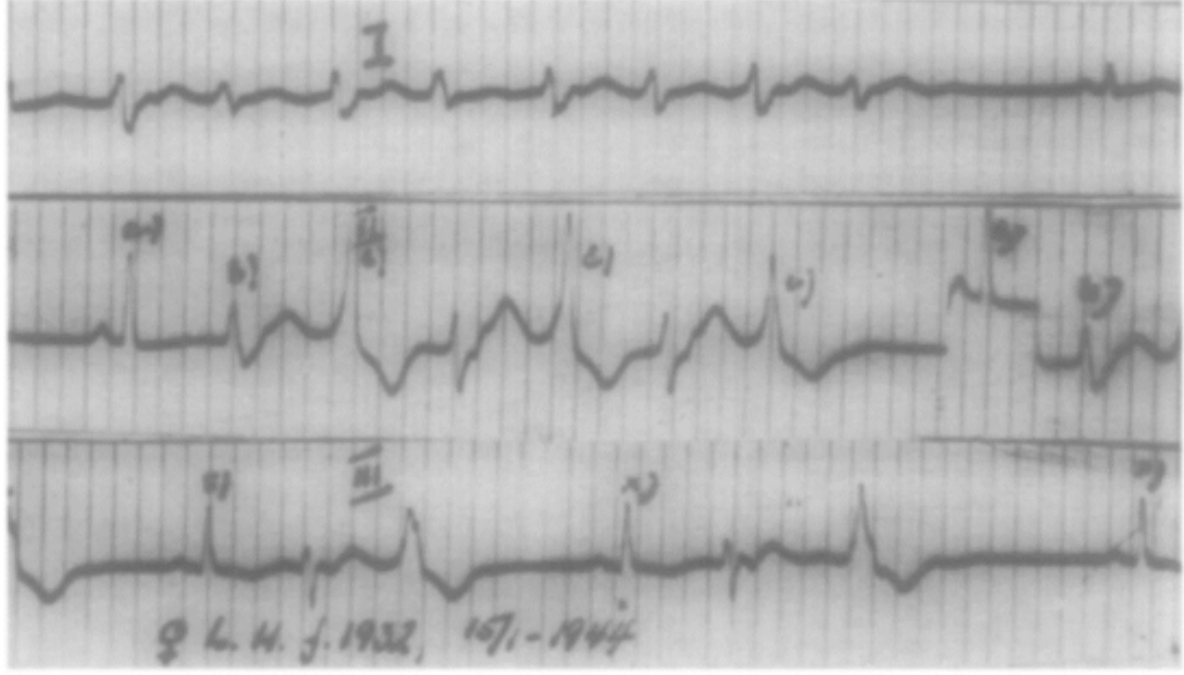
Figure 1. Historic electrocardiogram recording showing frequent ventricular extrasystole in 1944. Image obtained with permission from: Berg, K. J. (1960). Multifocal ventricular extrasytoles with Adams–Stokes syndrome in siblings. American Heart Journal , 60(6), 965–970.